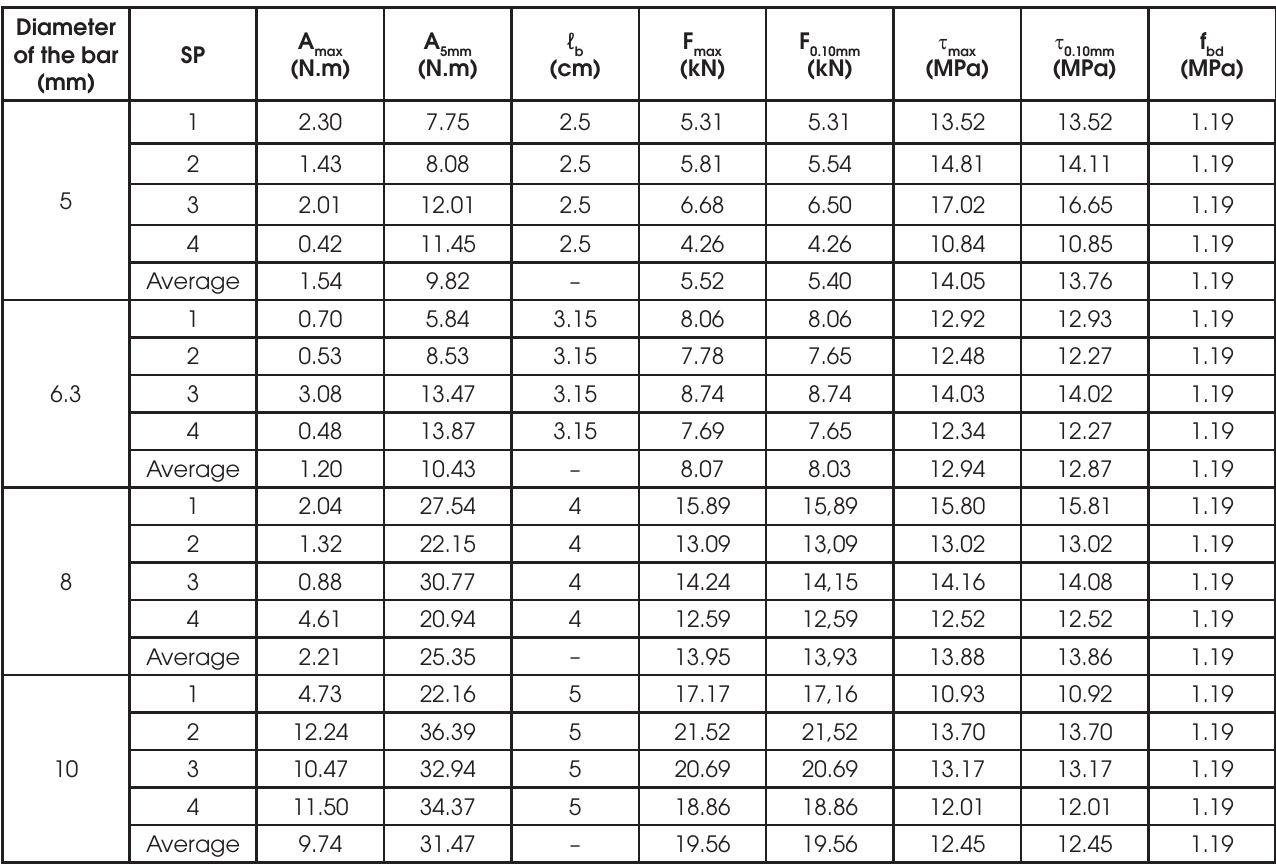
Adherence between steel bars and lightweight concrete with EPS beads